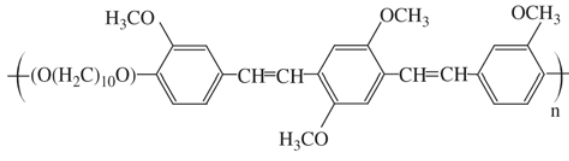
Figure 1. Chemical Structure of OPPVDBC; R. Lessmann et al.